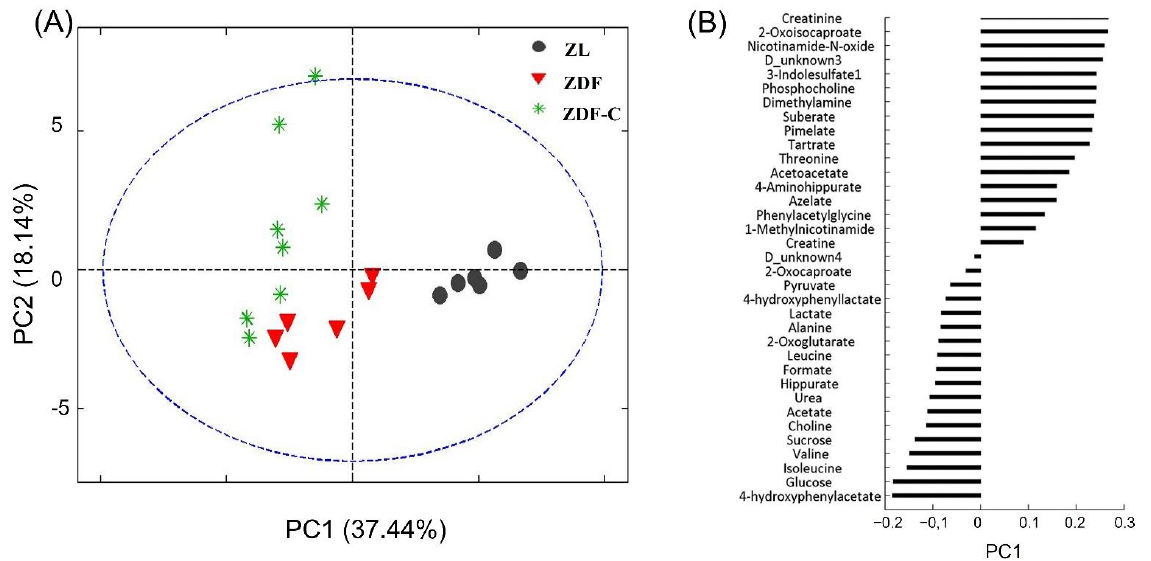
Figure 1. ( A ) Principal components analysis (PCA) score plots from urine samples from normal lean plot of (ZL), diabetic (ZDF), and cocoa-supplemented diabetic (ZDF-C) rats, at 20 weeks of life. ( B ) Loading plot of PC1.